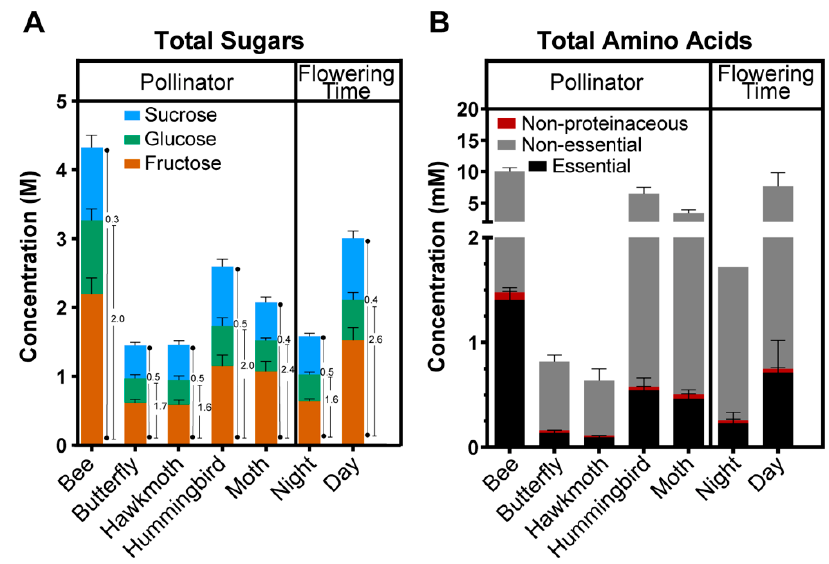
Figure 5. Sugar and amino acids profiles of Nicotiana nectars categorized by the preferred pollinator and time of flowering. ( A ) Sum of total sugar content highlighting the contributions of the three main sugars, sucrose, glucose and fructose. The numbers beside each data-bar is the sucrose: hexose molar ratio (closest to the data-bar) and the fructose: glucose ratio (furthest from data-bar). ( B ) Sum of total amino acid content in nectar categorized as nonproteinaceous, essential, and nonessential amino acids. Error bars represent the standard error, from 18 to 48 replicates depending on pollinator or flowering time.